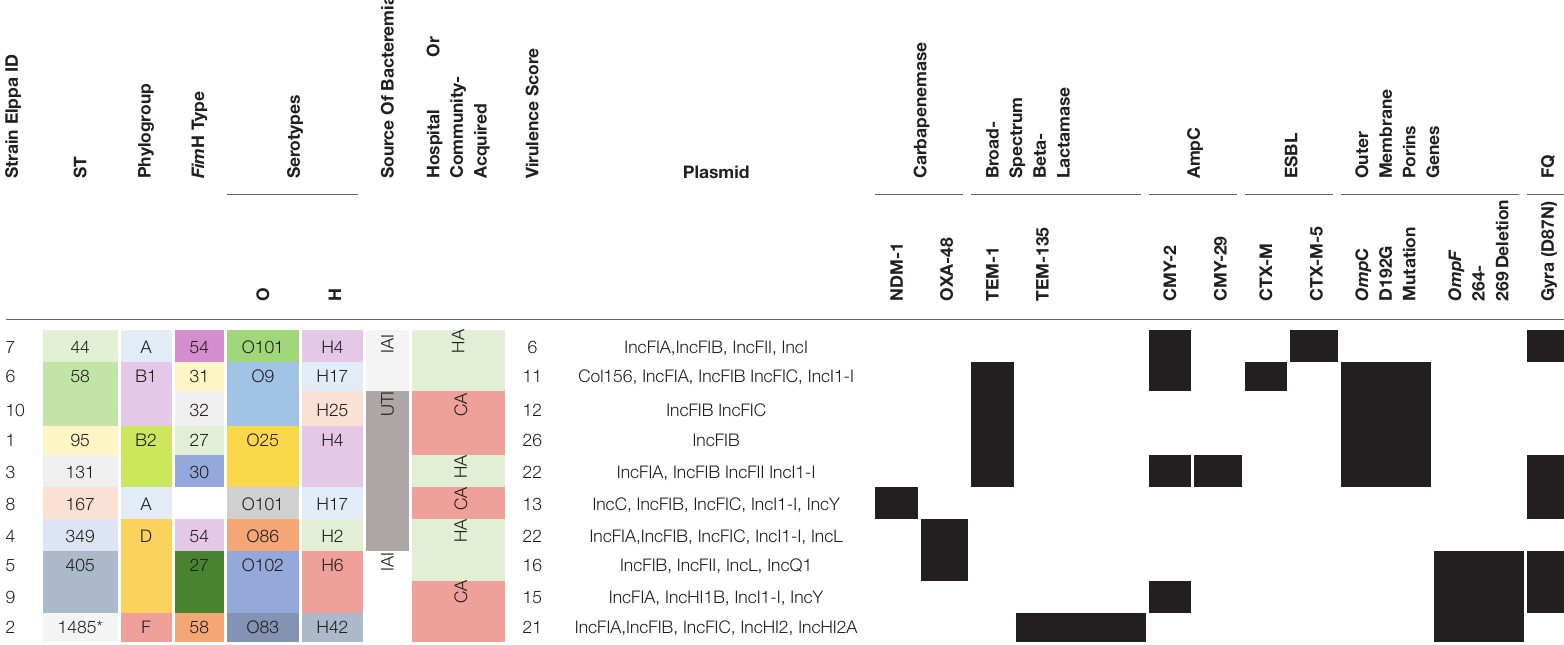
Virulence score is the number of virulence genes that were detected in an isolate. CA, community-acquired; FQ, fluoroquinolone; HA, hospital-acquired; IAI, intraabdominal infection; ST, sequence type; UTI, urinary tract